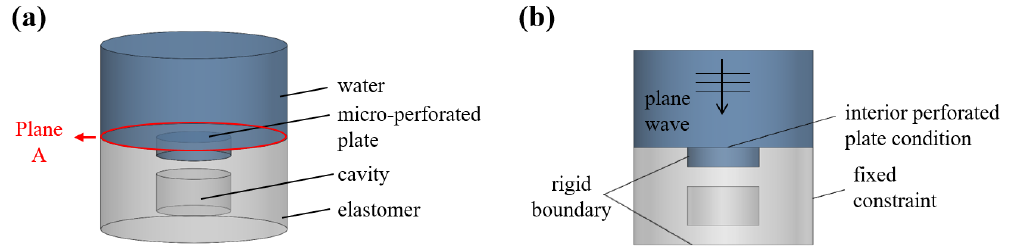
Figure 5. Simulation model for analyzing the sound absorption coefficient of the developed hybrid sound-absorbing metastructure: ( a ) simulation setup and ( b ) boundary conditions.